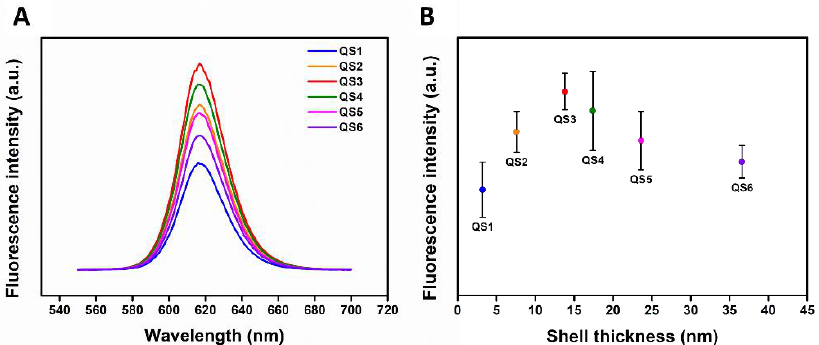
Figure 3. ( A ) Fluorescence spectra of SiO 2 @Ag@SiO 2 @QD with different silica shell thickness and ( B ) its intensity at 620 nm.